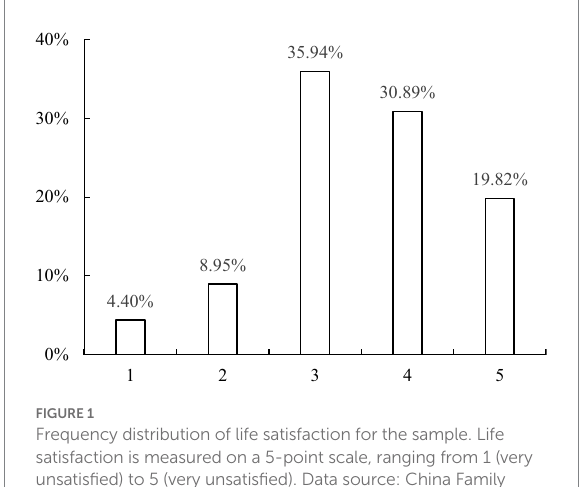
FIGURE 1 Frequency distribution of life satisfaction for the sample. Life satisfaction is measured on a 5-point scale, ranging from 1 (very unsatisfied) to 5 (very unsatisfied). Data source: China Family Panel Studies 2010, 2012, and